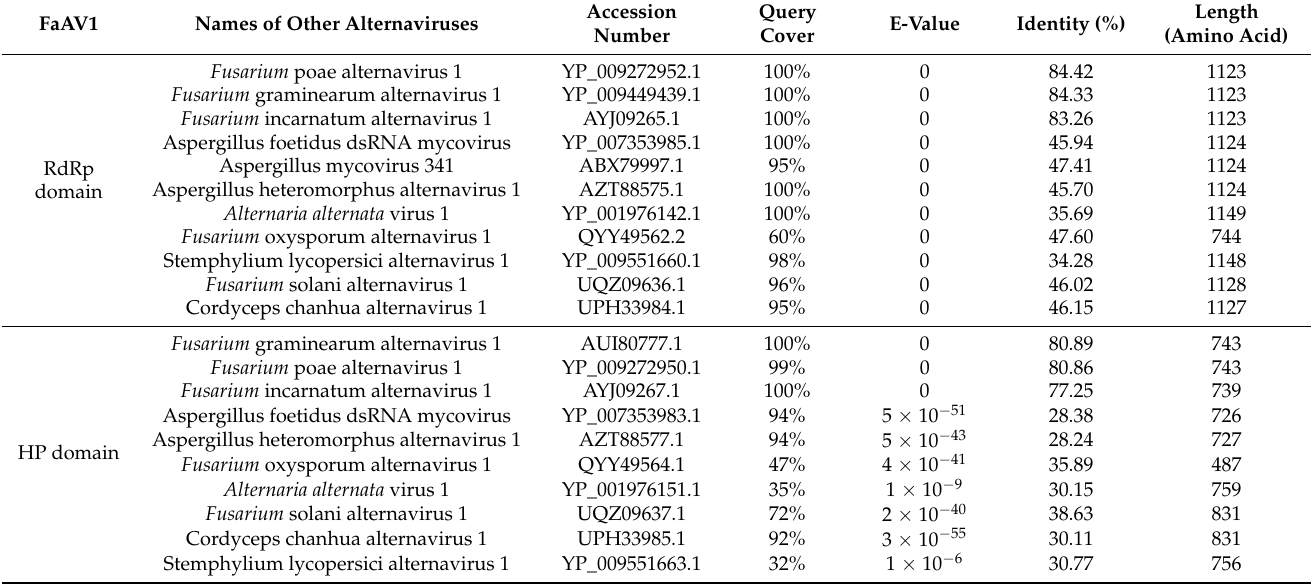
Table 2. Amino acid sequence identity of RNA dependent RNA polymerase (RdRp) and hypothetical protein (HP) of Fusarium avenaceum alternavirus 1 (FaAV1) to other